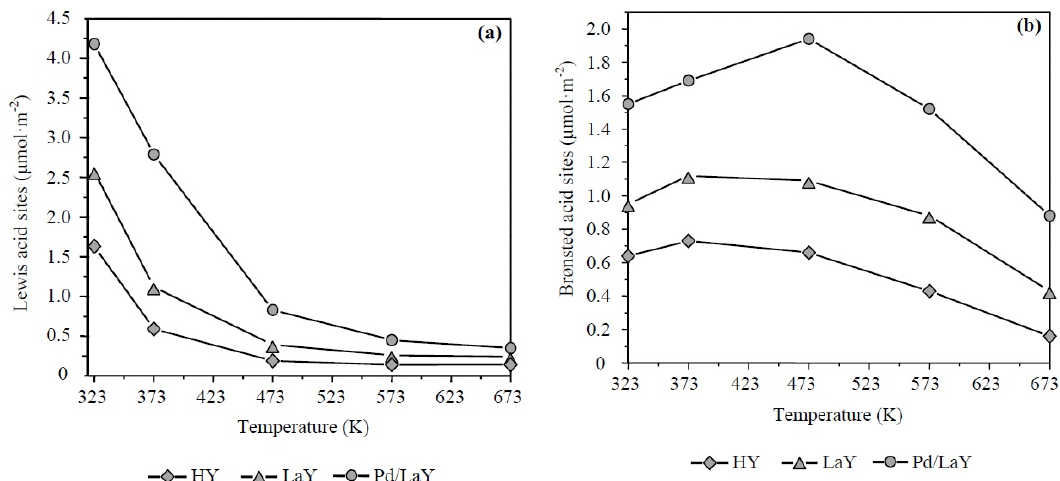
Figure 7. Quantification of ( a ) Lewis and ( b ) Brønsted acid sites of HY, LaY, and Pd/LaY zeolites at different temperatures.